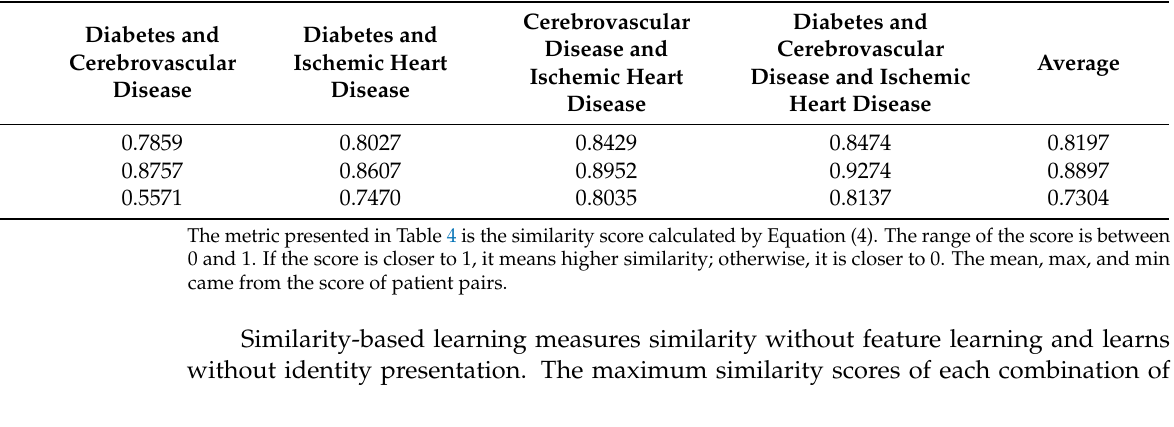
Table 4. Similarity-based learning